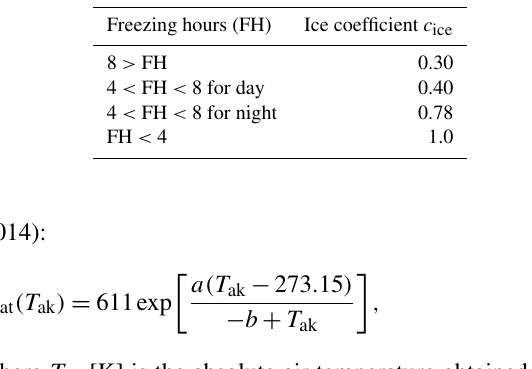
Figure A2. Diurnal averaged aerodynamic resistance observed above the water surface during the E-DATA, and the black lines are the prescribed values under calm and windy regimes. Table A1. Categorization of freezing hours and the ice